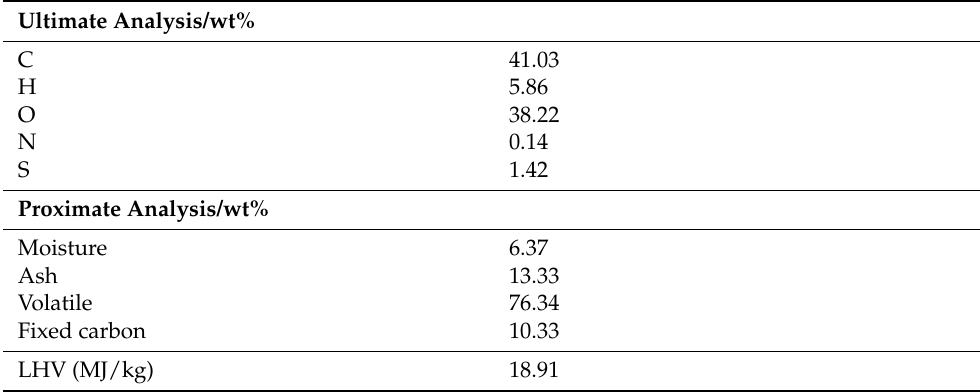
Table 1. Proximate and Ultimate analysis of the synthetic